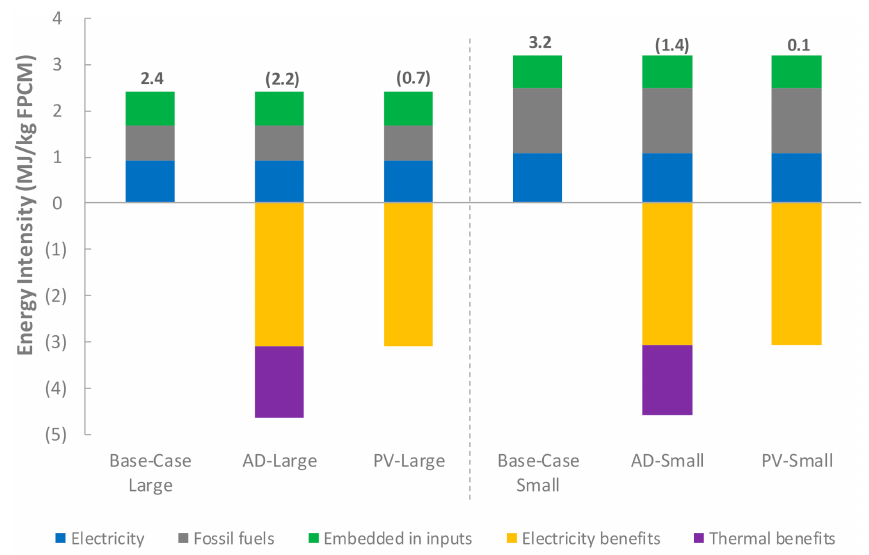
Figure 3. Net Energy Intensity (NEI) from the base-case large and small dairy farms (no renewable energy production), the same farms with AD systems (including solid-liquid separation), and the same farms with solar PV systems producing the same electricity than the corresponding AD